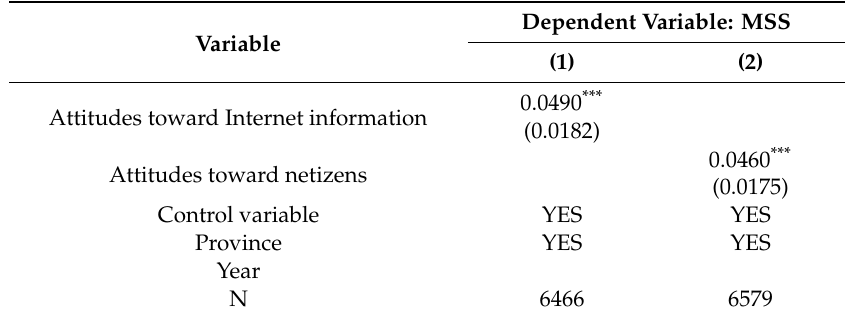
Table 4. Attitudes toward Internet and medical service